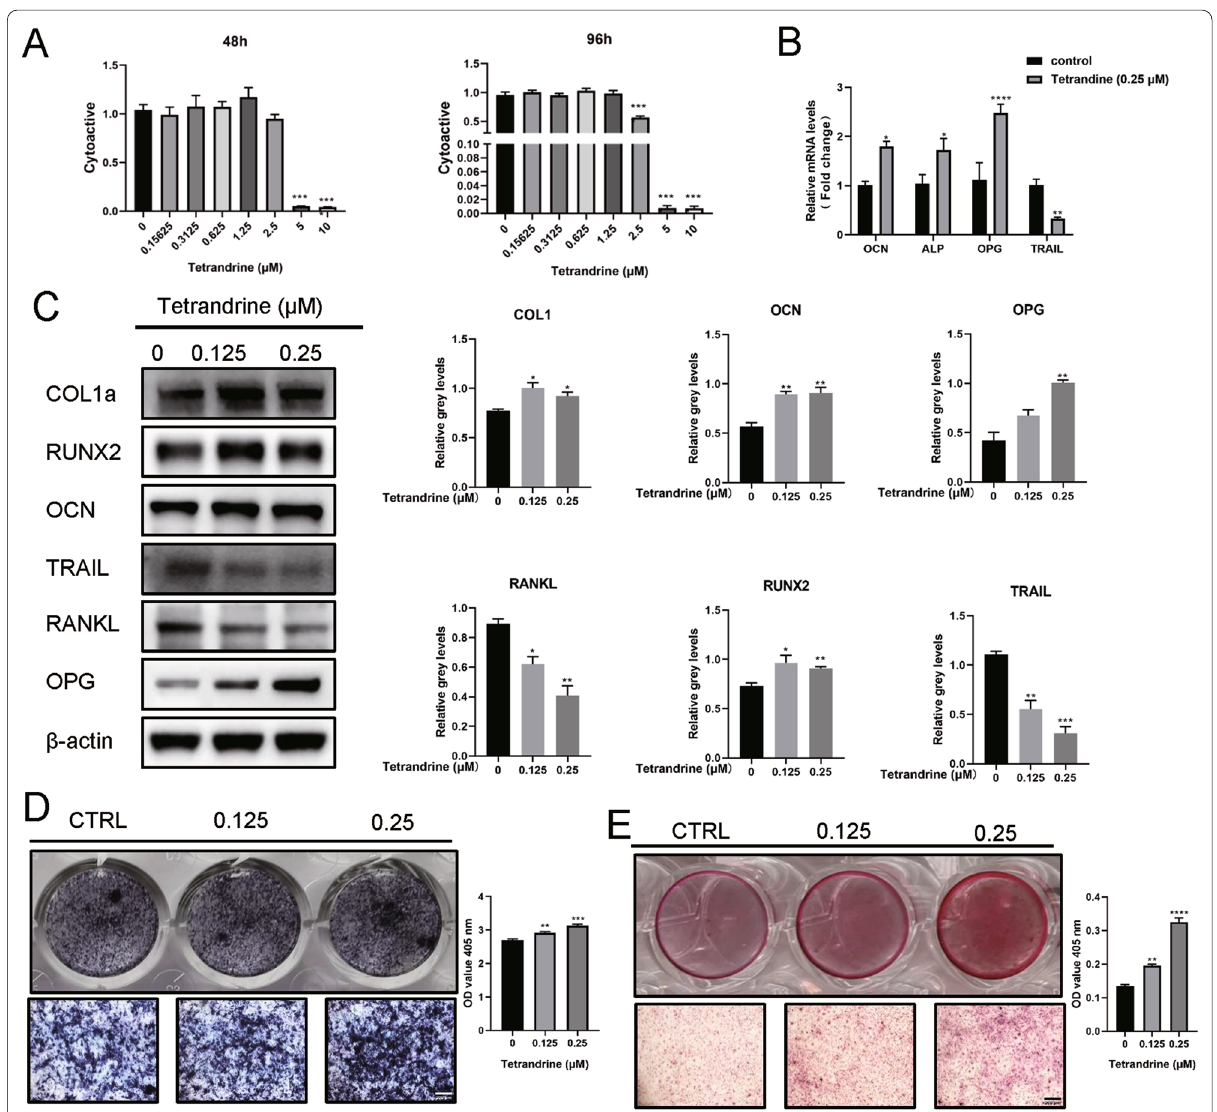
Fig. 7 Tetrandrine promotes C3H10 osteoblastogenesis and inhibits TRAIL expression in C3H10. A Effect of Tetrandrine on C3H10 viability by CCK-8 assay at 48 h and 96 h. B The TRAIL, OCN, ALP and OPG expression levels in C3H10 treated with Tetrandrine were detected with RT-qPCR. C The protein levels of COL1a, RUNX2, OCN, TRAIL, RANKL and OPG were measured with western blotting. D , E ALP and ARS expression in C3H10 following the treatment with various concentration of Tetrandrine for 7 days. The mineralized extracellular matrix was detected with Alizarin Red S staining for 14 days. The OD values obtained for ALP solutions and mineralized matrix solutions after their treatment with Tetrandrine; scale bar 200 μm. All experiments were carried out in triplicate. The results were presented as mean = **** P < 0.001 as compared with the control group